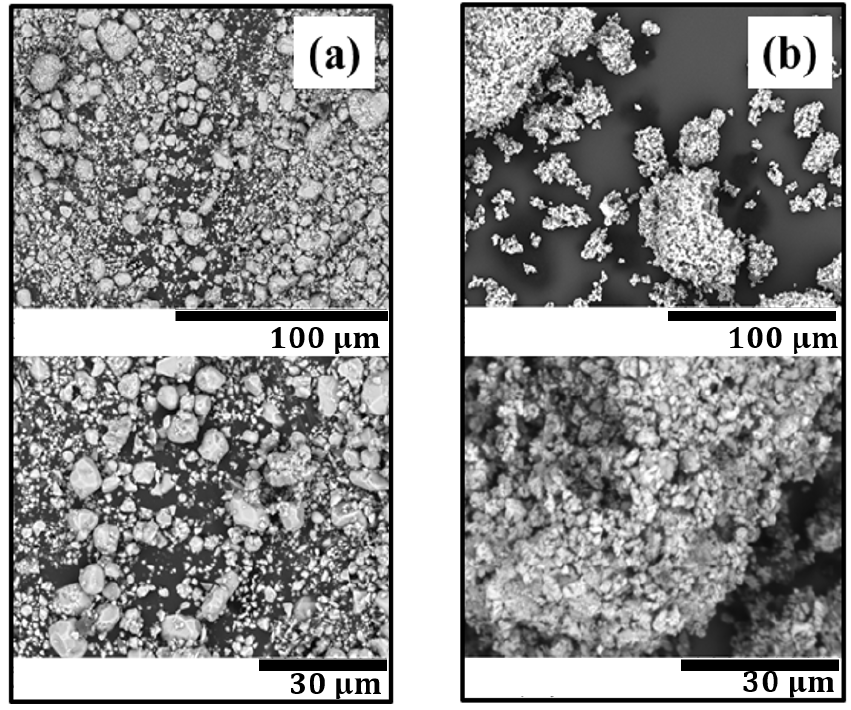
Figure 2. SEM images of precursor powders synthesized from: ( a ) conventional solid-state reaction (SSR) and ( b ) solution-assisted solid-state reaction (SASSR).